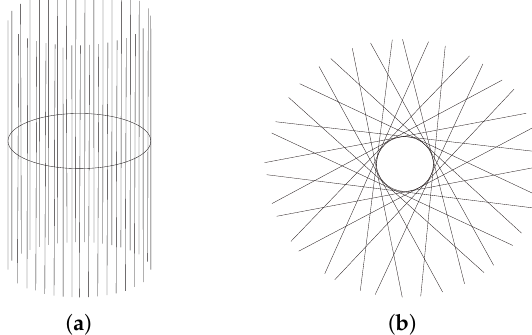
Figure 7. Illustration of a tangent bundle of a manifold. The figure illustrates the tangent bundle of a circle ( a ) viewed from the side and ( b ) viewed from the top or bottom.